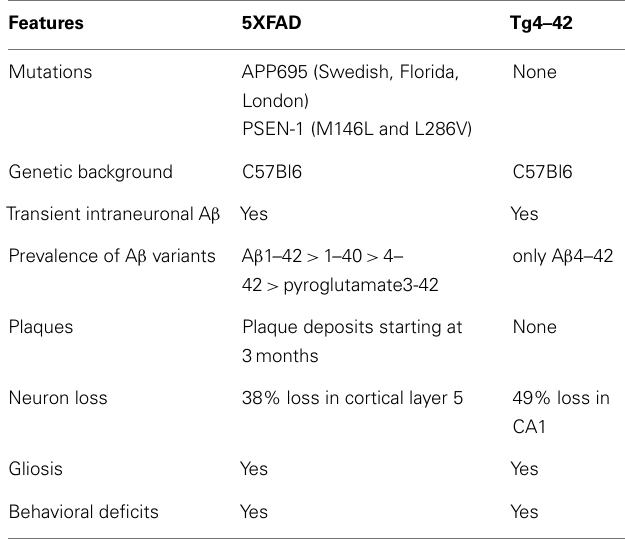
Table 6 | Comparison of the two transgenic mouse models 5XFAD